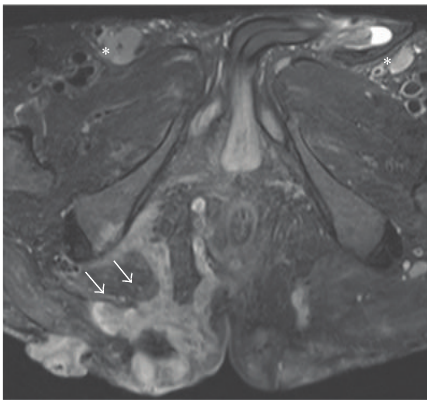
Figure 2: Coronal FSE T1-weighted fat-suppressed post-IV Mag- nevist 10 mls. Note: rim-enhancement of these collections post-IV contrast (white arrows), consistent with abscesses.